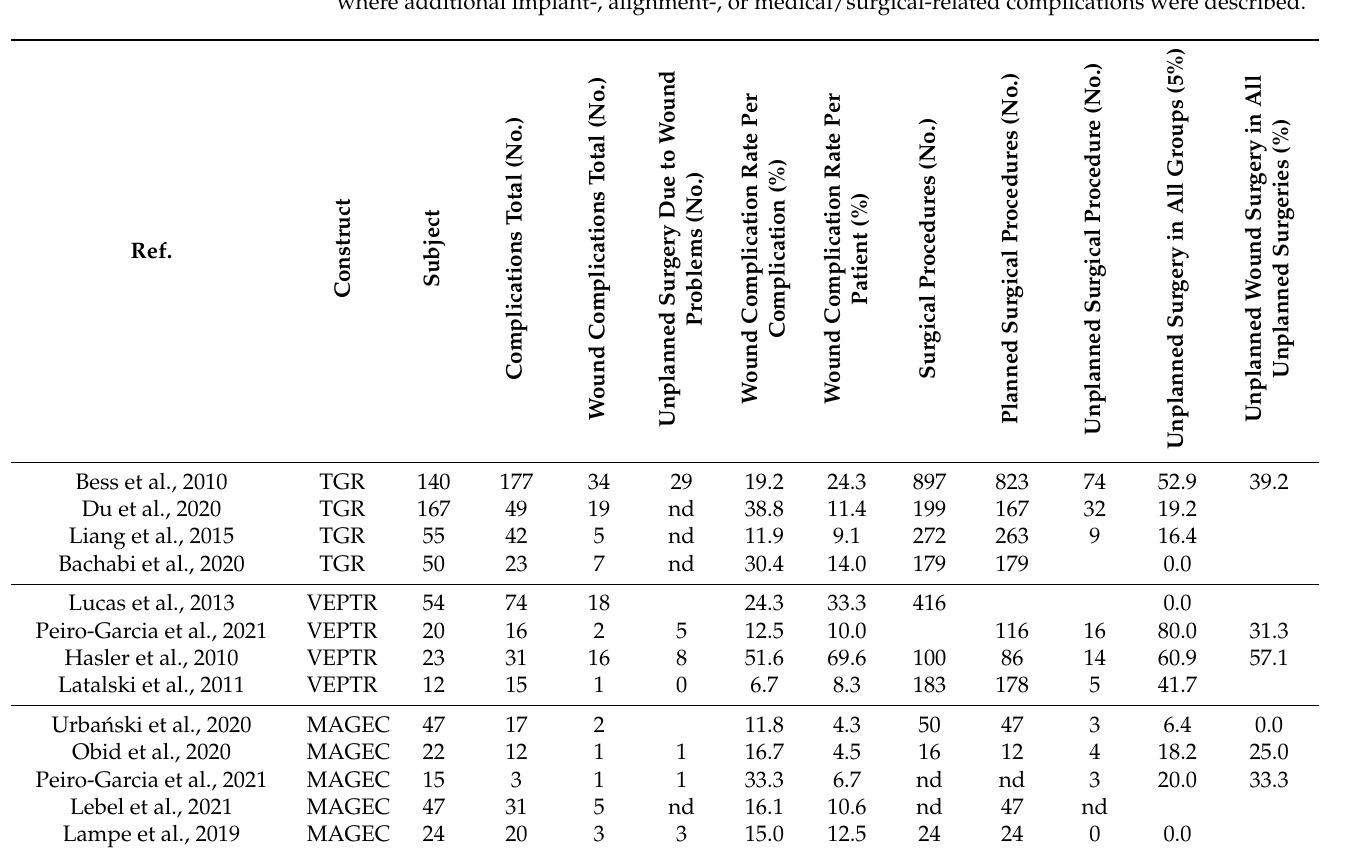
Table 2. Number of wound complications and unplanned surgeries analyzed in extracted papers where additional implant-, alignment-, or medical/surgical-related complications were